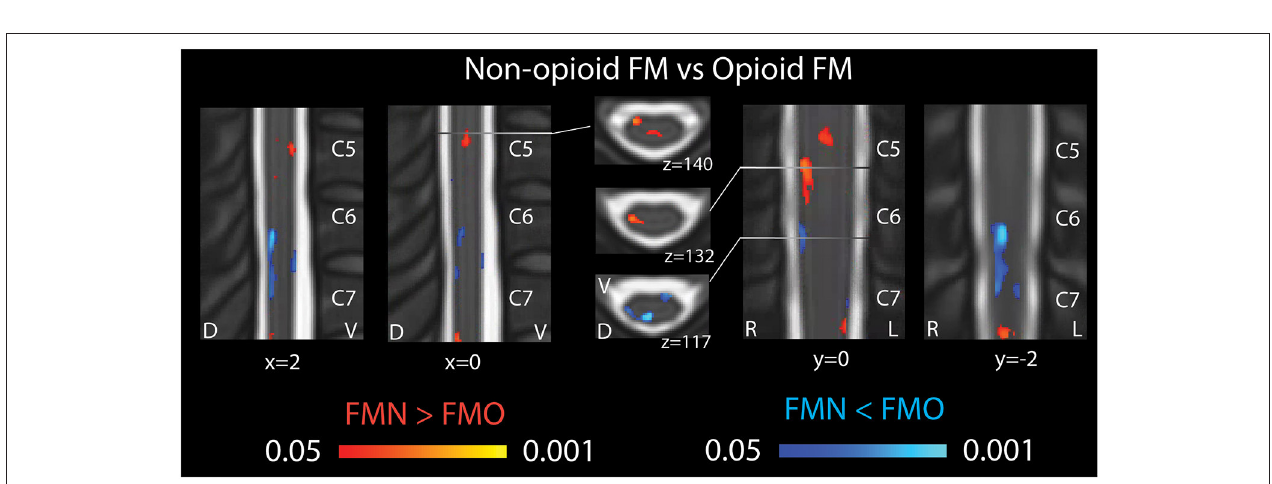
FIGURE 3 | Spinal cord regional mean ALFF differences in patients not taking opioids vs. patients taking opioids. Fibromyalgia patients who were not taking opioids (non-opioid FM) showed several spinal cord regions of greater Mean ALFF vs. patients taking opioids (opioid FM) (regions of red shading, FMN > FMO). Non-opioid fibromyalgia patients showed several spinal cord regions of lesser Mean ALFF vs. patients taking opioids (regions of blue shading, FMN < FMO). Sagittal images are indicated with “x” coordinate locations, coronal images are indicated with y coordinate locations, and axial images are indicated with “z” coordinate locations based on the PAM50 template (23). D, dorsal; FM, fibromyalgia; FMN, non-opioid FM; FMO, opioid FM; L, left; R, right; V, ventral. P -values are uncorrected <